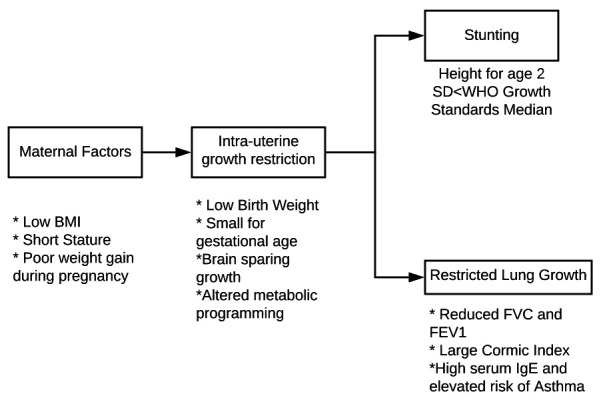
Intrauterine growth restriction contributes to both low lung function and stunting.